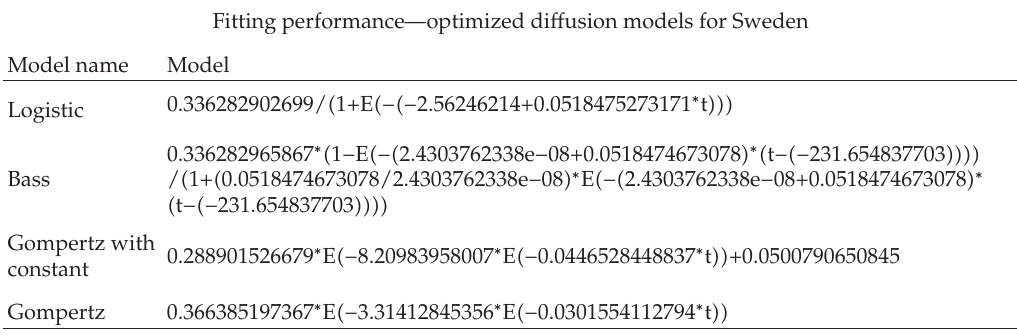
Table 24: Representation of the optimized di ff usion models in fitting (cid:2) Sweden (cid:3) . Fitting performance—optimized di ff usion models for Sweden